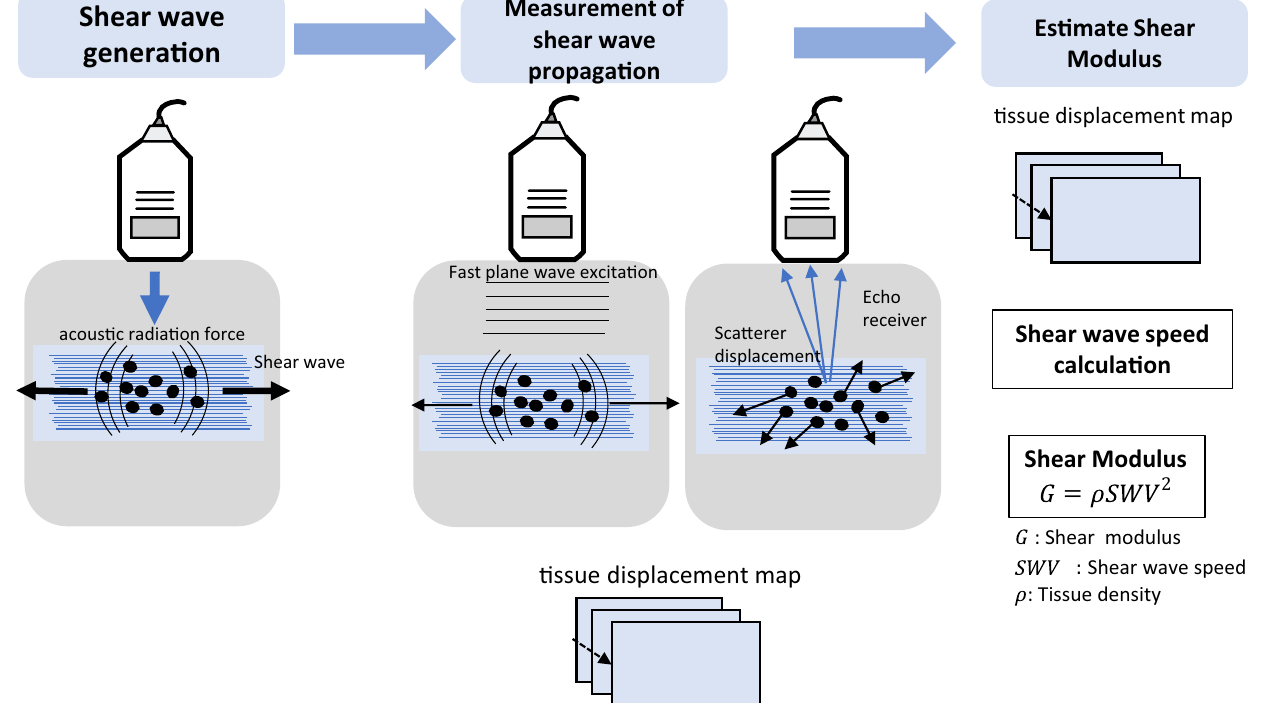
Fig. 2 Basic physical principle of shear-wave elastography (SWE). A perpendicular stress force (acoustic radiation force) is applied to the tissue, which causes the generation of shear waves. The velocity of the shear wave couldbemeasuredbyobtaining radiofrequency imageswith a